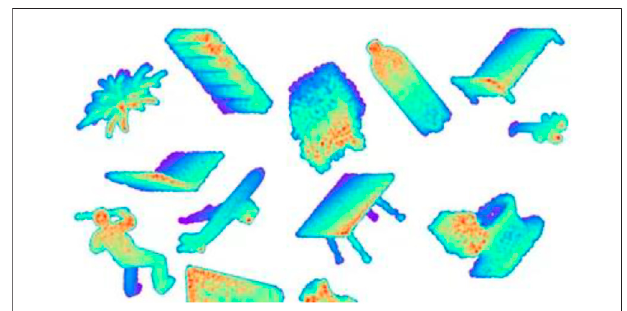
FIGURE 2 | Point cloud examples of ModelNet40.